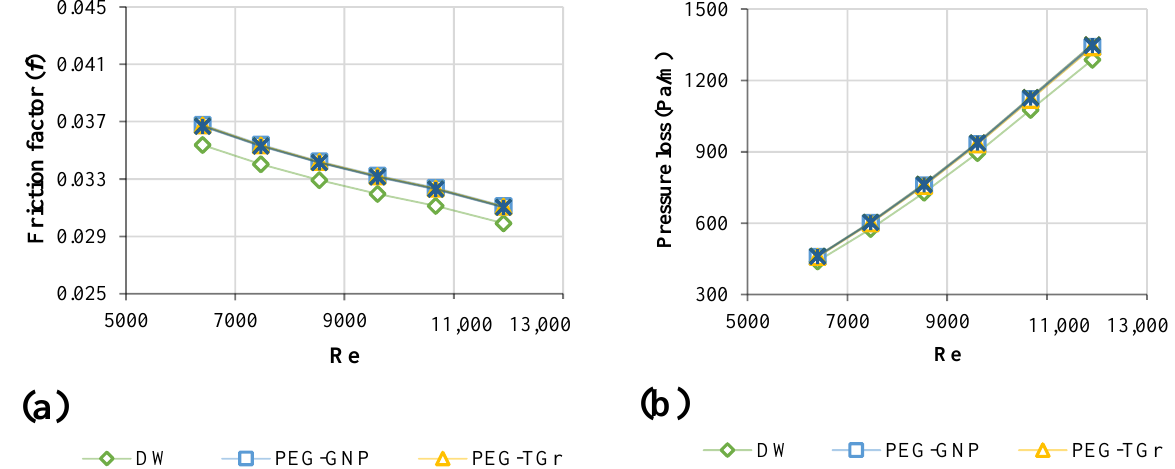
Figure 8. Hydrodynamic properties of different nanofluid types against Reynolds number; ( a ) Friction factor, ( b ) Pressure drop.